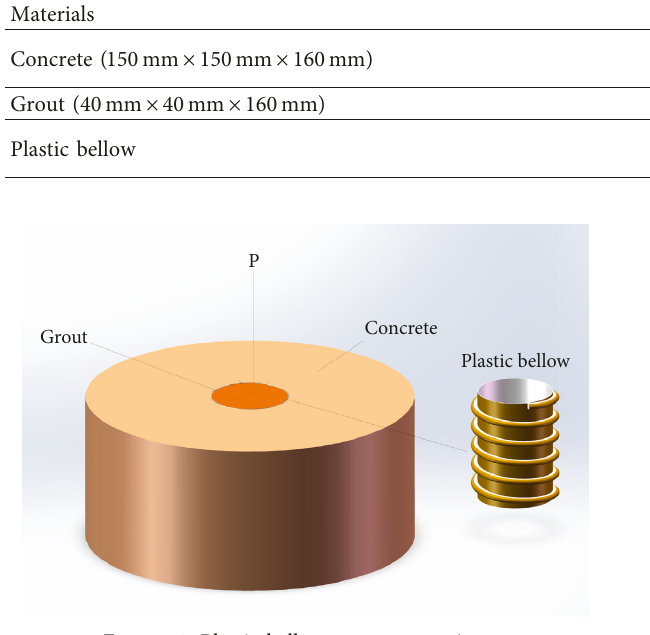
Figure 1: Plastic bellow concrete specimen.